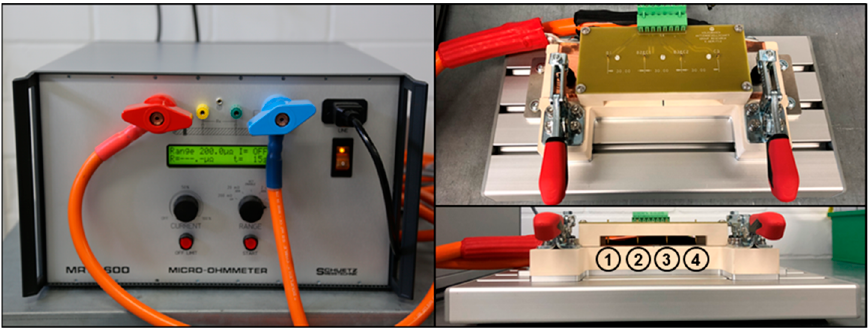
Figure 1. Setup for electrical resistance measurement.